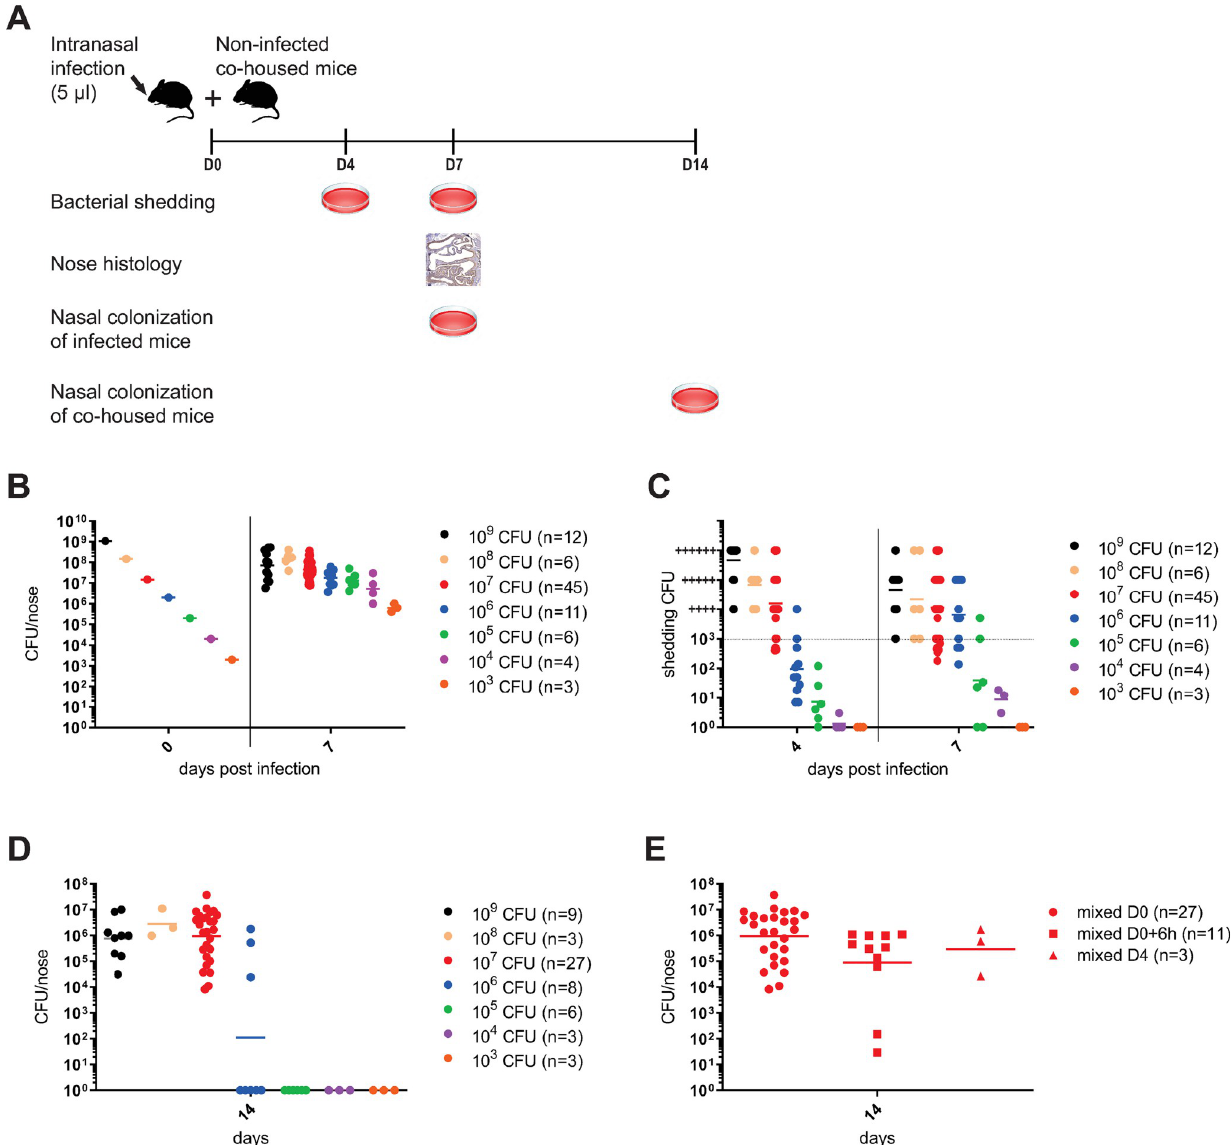
Fig 4. High bacterial proliferation in the nasal cavity triggers efficient nasal shedding and robust B . pertussis transmission between adult MyD88 KO mice. ( A ) Schematic depiction of the design of inoculation, nasal shedding, bacterial transmission and pathology assessment experiment. Nares of mice were inoculated with 5 μ l of suspension containing indicated CFU content and inoculated index mice were placed into the same cage with non-inoculated recipient mice at a 1:1 ratio for co-housing. On days 4 and 7 nasal shedding of bacteria by index mice was determined by tapping their noses on BG plates and the index mice were next sacrificed for determination of bacterial loads in their nasal cavities and histological analysis of nasal cavity pathology. Co- housed recipient mice were kept for one week more and transmission-acquired B . pertussis loads in their nasal cavities were determined. ( B ) Nares of MyD88 KO mice were inoculated with 5 μ l of bacterial suspensions containing from 10 3 to 10 9 CFU of B . pertussis cells and bacterial loads in infected nasal cavities were determined on day 7 by plating of nose homogenates. ( C ) Prior to euthanasia, B . pertussis shedding from the nasal cavities of infected mice was quantified on days 4 and 7 as described above. Shedding exceeding 10 3 CFU per mouse nose/plate (dotted line) prevented more accurate CFU counting and its level was estimated from the density of the confluent B . pertussis lawns growing on BG agar and scored by the number of + signs indicating the estimated order of magnitude of shed bacterial numbers. ( D ) Index MyD88 KO mice inoculated into nares with the indicated dose of B . pertussis CFUs were co-housed in the same cage in a 1:1 ratio with non-inoculated recipient MyD88 KO mice for 7 days before the index mice were withdrawn for determination of nasal shedding and nasal cavity bacterial loads. The co-housed recipient mice were kept for another week prior to determination of bacterial loads in their nasal cavities on day 14. ( E ) In parallel, further index MyD88 KO mice inoculated with 10 7 CFU of B . pertussis were kept in separate cages for 6 hours or 4 days before being brought in contact and co-housed in a 1:1 ratio over 7 days with the non-infected recipient mice and nasal shedding, nose colonization level and transmission to recipient mice was analyzed as above. Dots represent bacterial counts for individual mice. Horizontal bars indicate the geometric means. The data for mice inoculated with 10 7 CFU were pooled for the 45 mice used in nine independent experiments (n = 45). The number of mice used per infection dose is given in brackets.